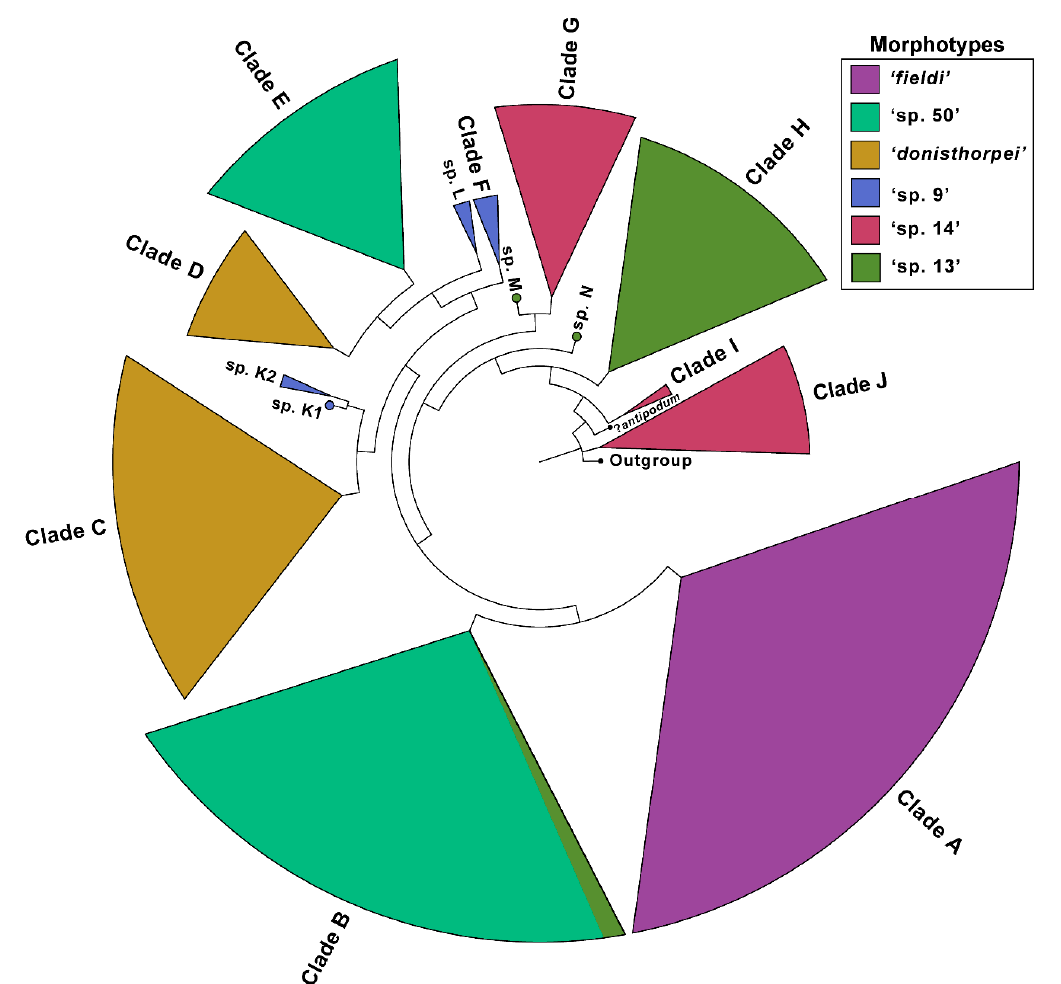
Figure 3. Summary CO1 tree showing the ten major clades (A–J) and distribution of the six mor- photypes (see Figure 2). types (see Figure